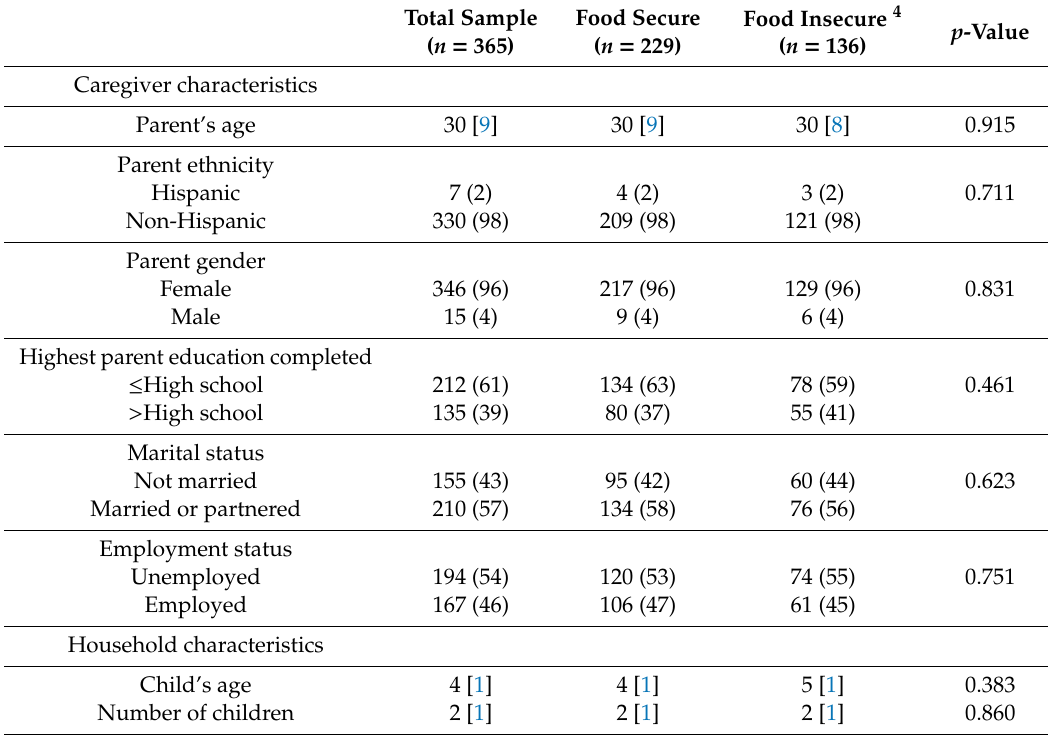
Table 1. Descriptive characteristics of a sample of low-income Head Start families with preschool- aged children from four rural counties in central Pennsylvania, USA, by household food insecurity status, ( n = 365) 1,2,3